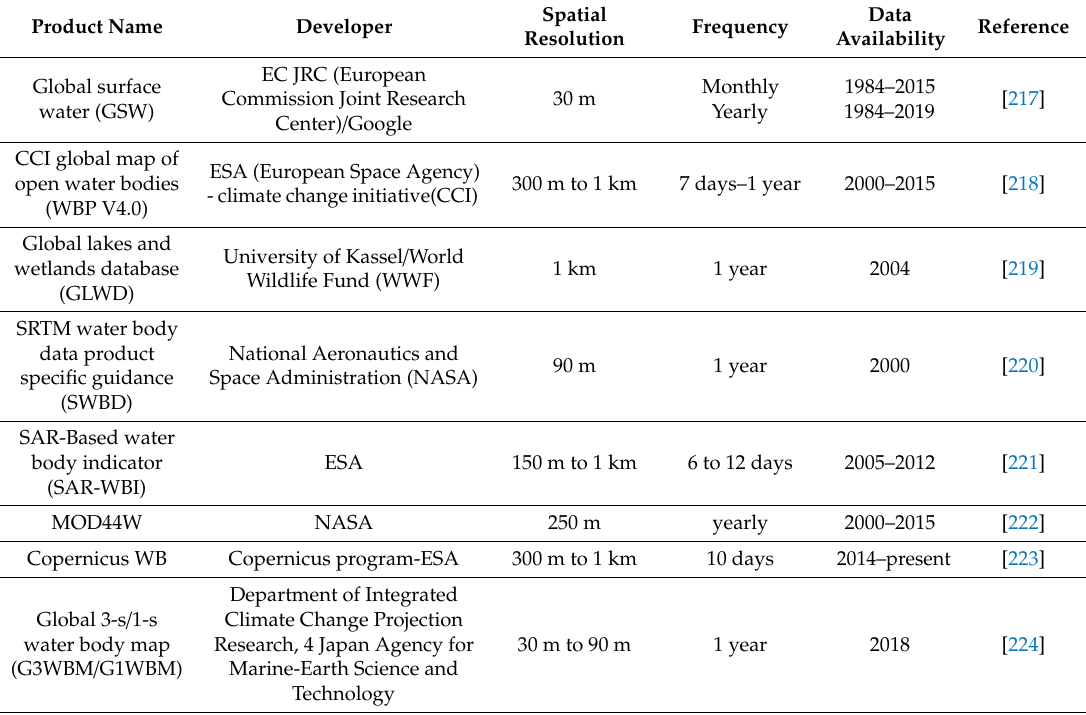
Table 5. Non-exhaustive list of remote sensing-based water